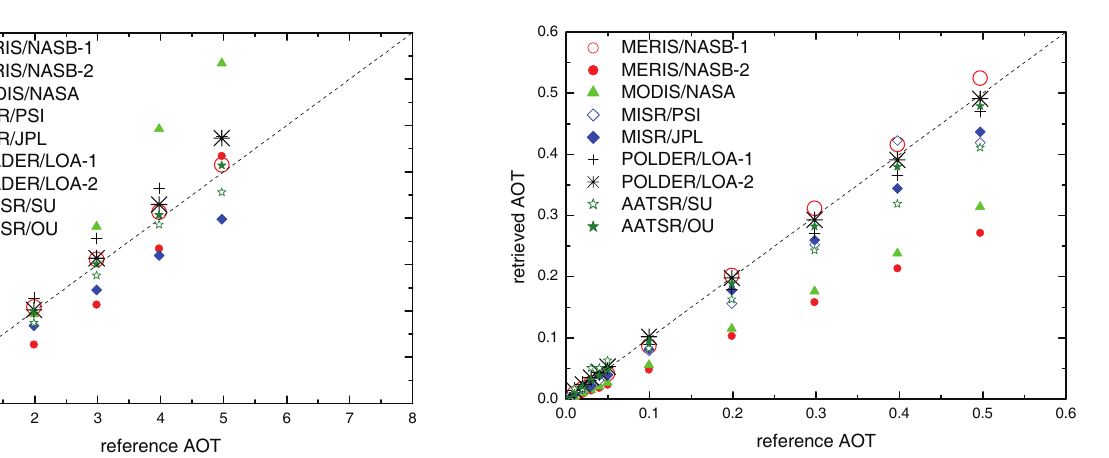
Fig. 9a. The correlation plot between the retrieved and reference AOT (550nm).